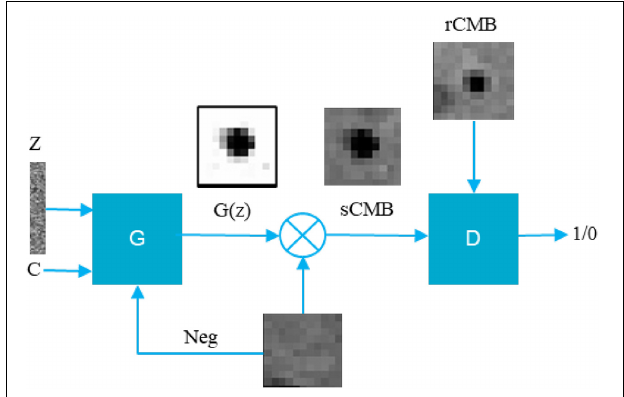
FIGURE 1 | Proposed conditional LesionGAN pipeline to generate sCMB. Z, noise; C, condition; G(z), cerebral microbleed partial volume mask; Neg, negative patch; G, generator; D,